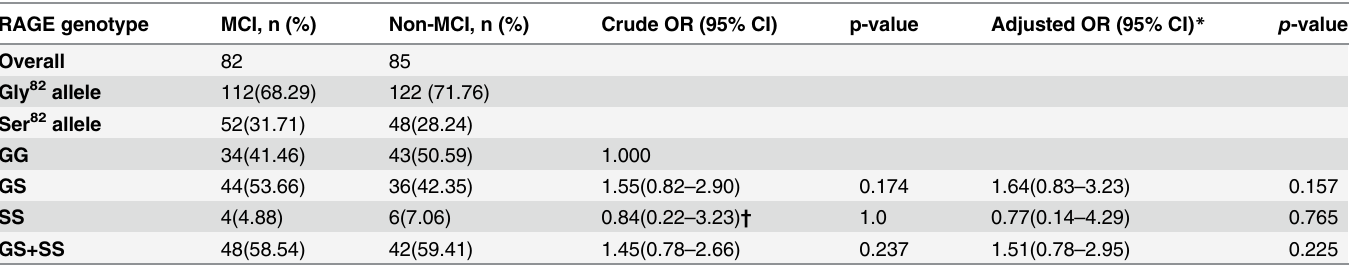
Table 3. Distributions of the RAGE genotypes and risk estimates for type 2 diabetes mellitus patients with MCI or normal cognition. RAGE genotype